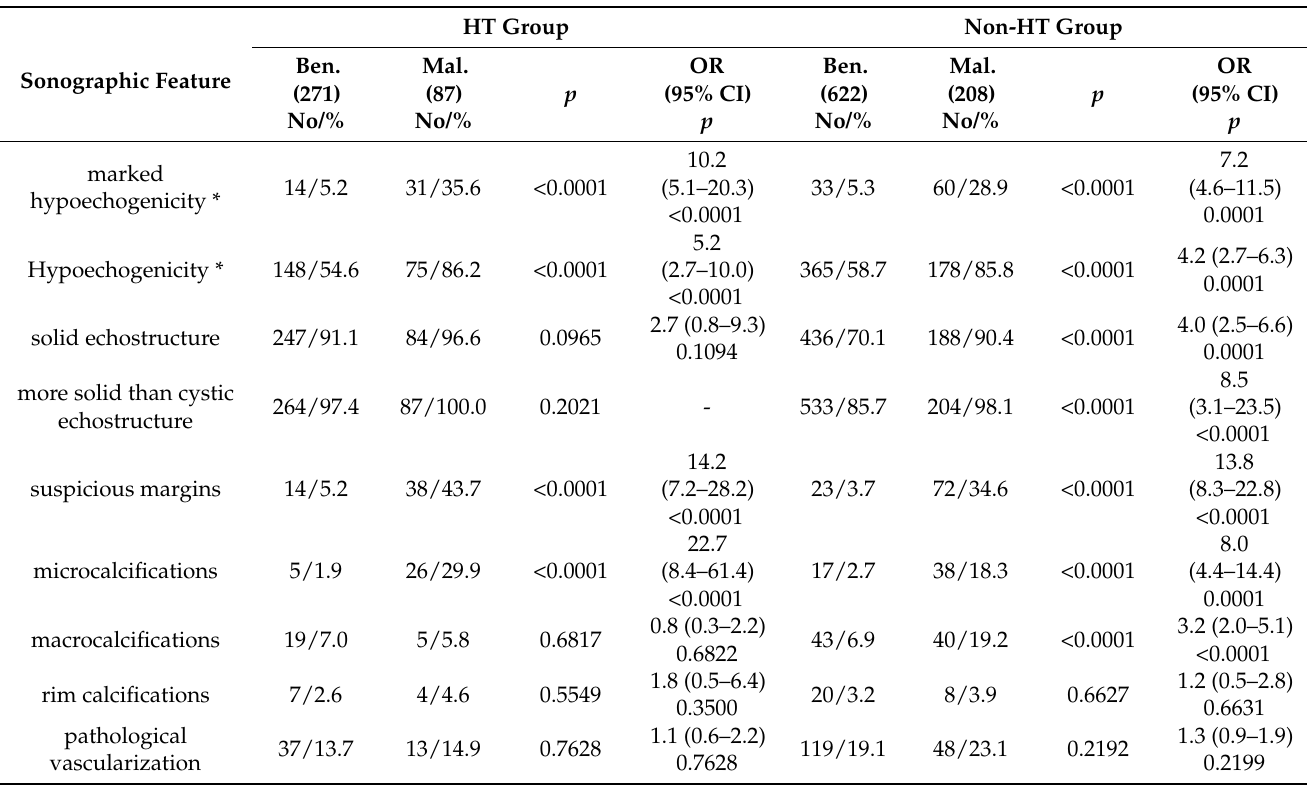
Table 2. Comparison of the incidence of sonographic features other than suspicious nodule’s shape in HT and non-HT nodules in relation to the histopathological outcome: benign lesion vs. thyroid malignancy. Results of univariate logistic regression analysis in both